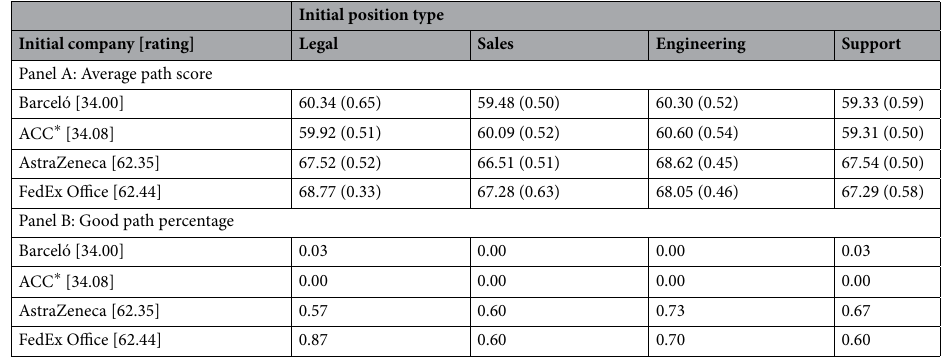
Table 2. Career path planning based on different initial companies and positions. This table summarizes the average path scores and good path percentage based on experiments with different initial companies and position types. We selected four companies (two average-rating companies and two high-rating companies) and four position types, leading to 16 combinations for the investigation. For each combination, 30 independent experiments were conducted. Panel A reports the average path score of the recommended career paths, along with corresponding standard errors (in parentheses). Panel B reports the “good path” percentages based on the same experiments. We define a good career path as one with a score greater than 66.62. *ACC: American Campus Communities